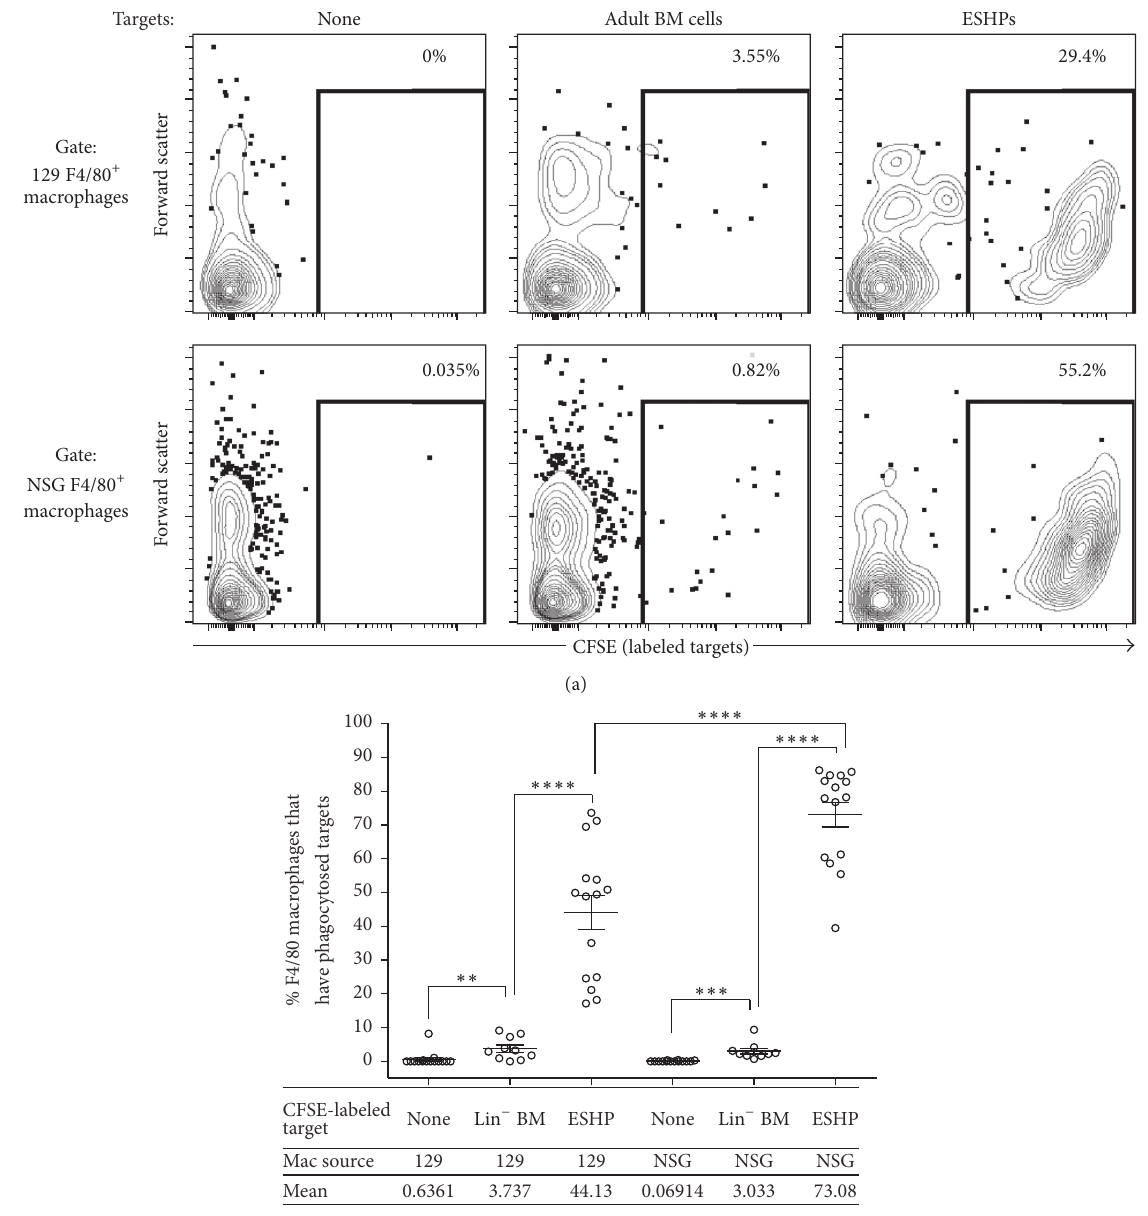
Figure 4: NSG macrophages preferentially phagocytose ESHP in vitro . (a) Representative contour plots of CFSE-labeled targets (ESHP or 129 Lin − BM) internalized by NSG F4/80 + macrophages in vitro . (b) Quantification of targets internalized by F4/80 + macrophages. 129 macrophages alone ( 𝑛 = 15 ), 129 macrophages with syngeneic 129 Lin − BM ( 𝑛 = 10 ), 129 macrophages with syngeneic ESHP ( 𝑛 = 15 ), NSG macrophages alone ( 𝑛 = 14 ), NSG macrophages with allogeneic Lin − BM ( 𝑛 = 9 ), and NSG macrophages with allogeneic ESHP ( 𝑛 = 15 ). Bars represent mean ± SEM; ∗∗ 𝑝 < 0.01 ; ∗∗∗ 𝑝 < 0.001 ; ∗∗∗∗ 𝑝 < 0.0001